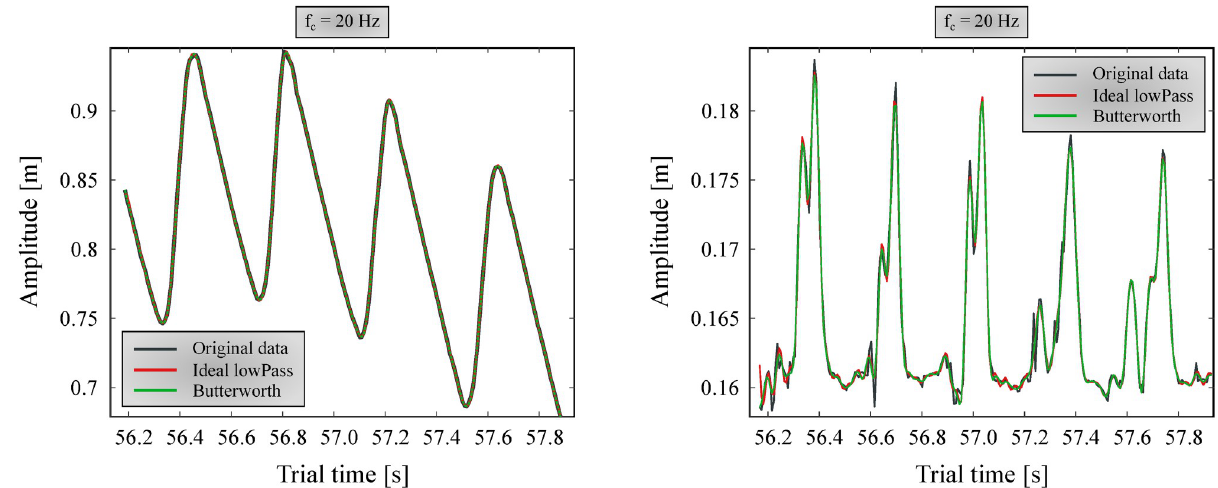
Fig 5. Position data of FR5 marker of the smallest dog filtered with f c = 20 Hz. Ideal low-pass and 6th order zero-lag Butterworth filters are shown in figure. Left: forward direction; Right: vertical direction.